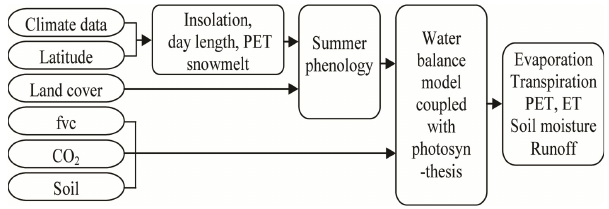
Fig. 1. A flowchart that describes the LH (LPJ-hydrology) model for calculating several hydrologic variables using climate, land cover, foliar vegetative cover (fvc), CO 2 and soil data. PET and ET are short for potential and actual evapotranspiration,